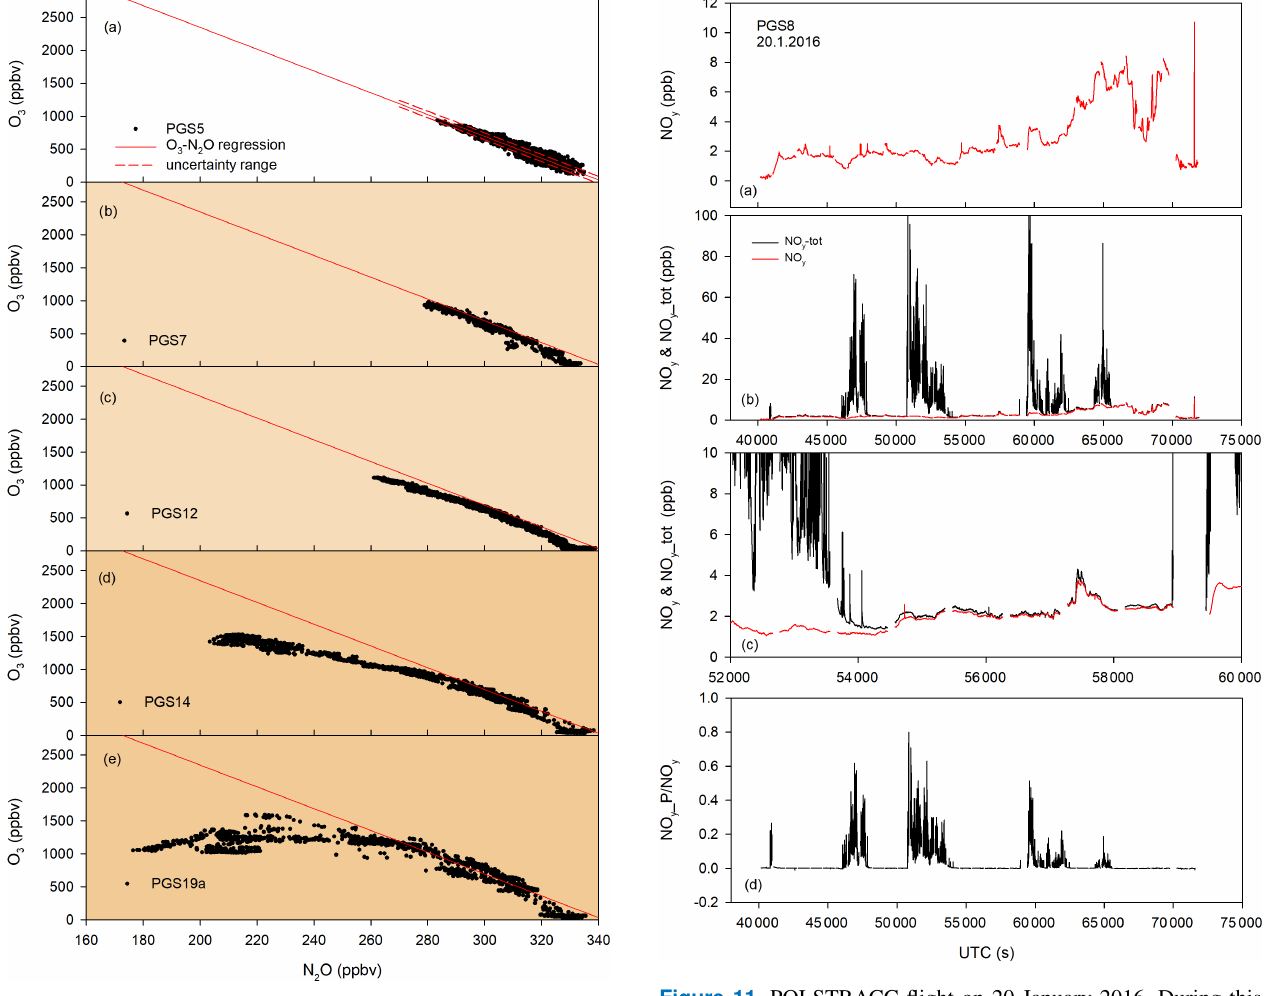
Figure 10. O 3 versus N 2 O for selected flights (same as in Fig. 6) in three observational phases. Early winter: PGS flight 5 – 21 De- ary 2016 and PGS flight 19a – 13 March 2016. Additionally, the regression line resulting from the December flight is given. The un- certainty range of the regression is indicated by dashed lines.